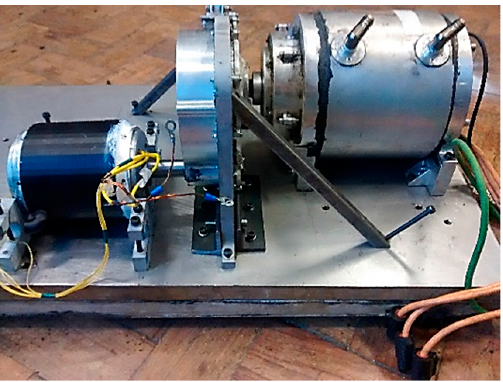
Figure 19. Test bench configuration with the prototype (left side) and Siemens motor (right side) mechanically coupled through a transmission gear.